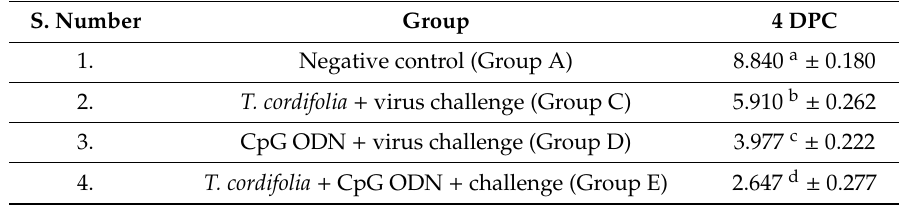
Table 13. Viral load (mean log 10 copy number ± SE) in the bursa of Fabricius (gene copy number by micrograms of total RNA) of chickens in di ff erent groups challenged with vvIBDV at 4 DPC. S. Number